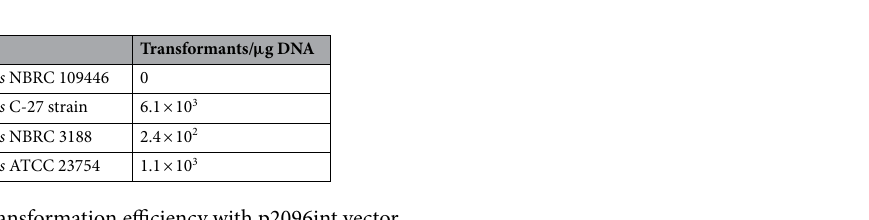
Table 2. Transformation efficiency with p2096int